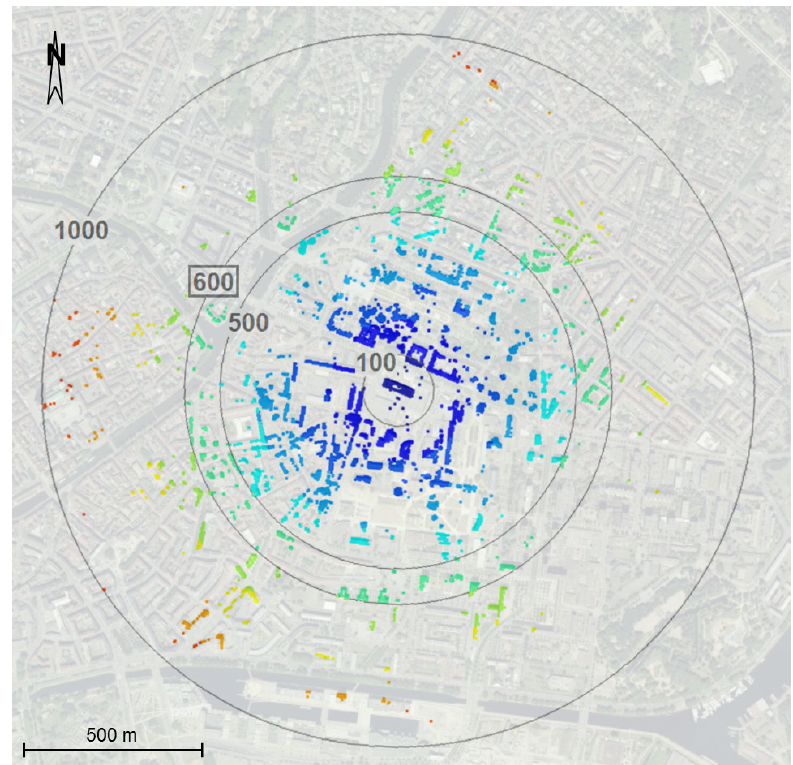
Figure 2. Top view of a 360° point cloud acquired in band scanning mode from a building roof. The point cloud is colorized according to range and significant ranges are represented. Table 5. Percentage of points contained in each 100 m portion around the scanner